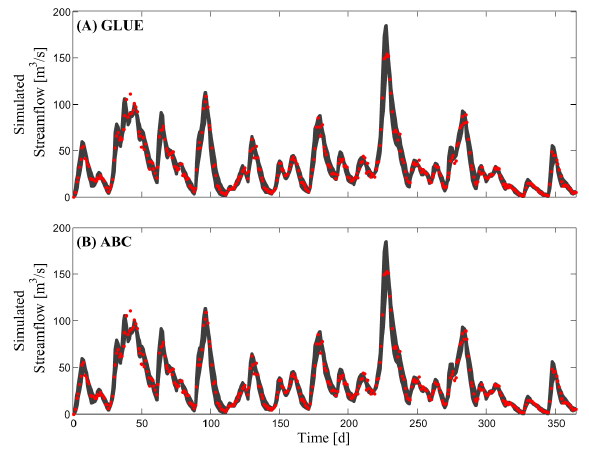
Fig. 4. 95% streamflow uncertainty ranges (dark region) derived from GLUE (top panel) and ABC (bottom panel). The red points mark the actual discharge observations. The prediction uncertainty ranges derived with both methods appear virtually identical and nicely capture the desired percentage of streamflow